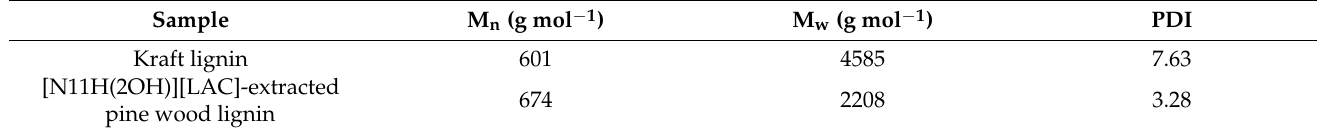
Table 1. Molecular weight properties of [N11H(2OH)][LAC]-extracted lignin from pine wood biomass and commercial Kraft lignin.